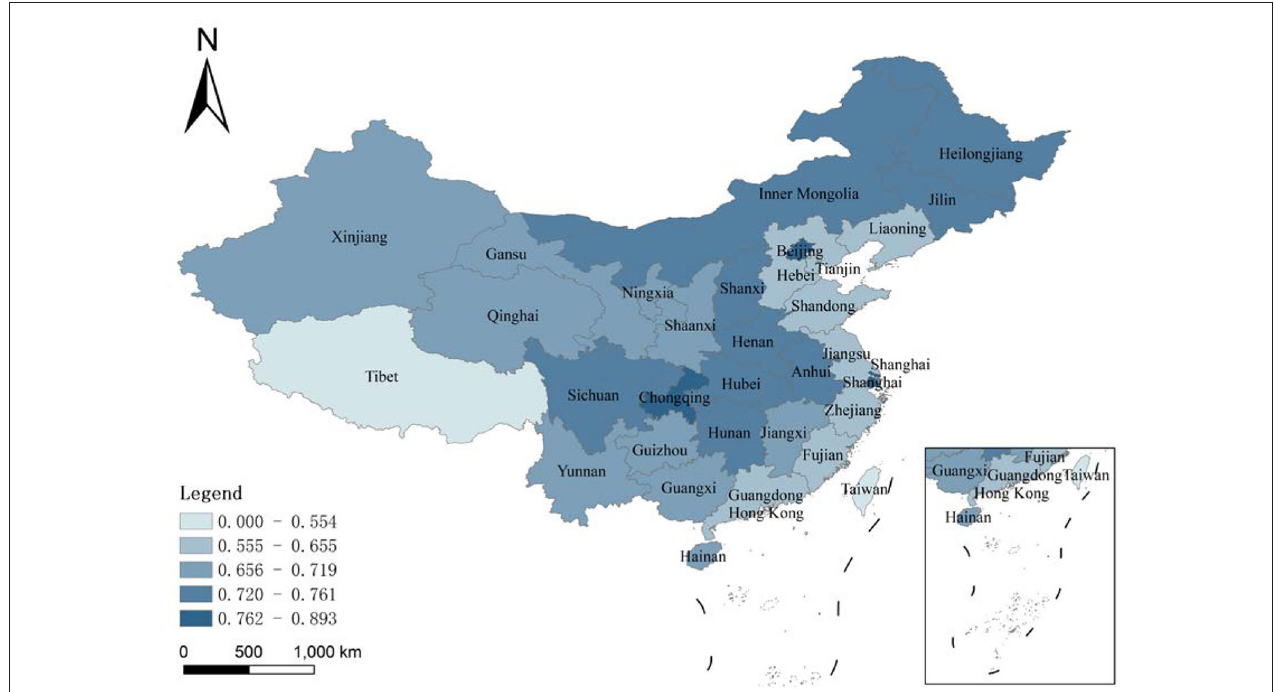
FIGURE 3 | Average innovation efficiency of the high-tech industry under the regional frontier in 1999–2018.